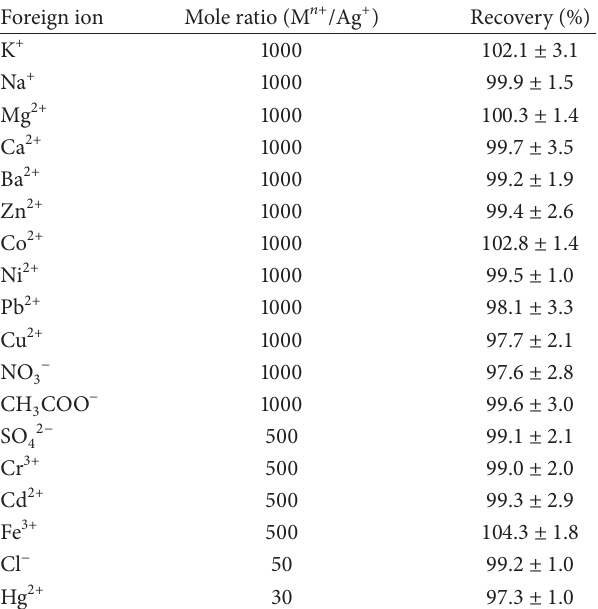
Table 1: Effect of foreign ions on the recovery of 5 𝜇 g of silver ions from 100mL of aqueous